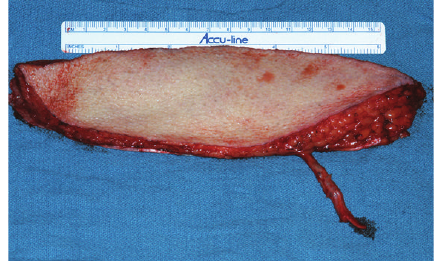
Figure 1: The anterior lateral thigh flap o ff ers excellent soft tissue volume for reconstruction with minimal donor site morbidity. It can be harvested in multiple composite configurations with skin, fascia, and muscle as well as tensor fascia lata. Note excellent pedicle length.